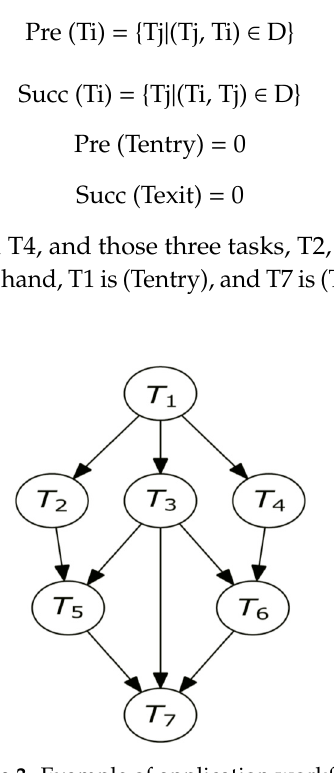
Figure 3. Example of application workflow.